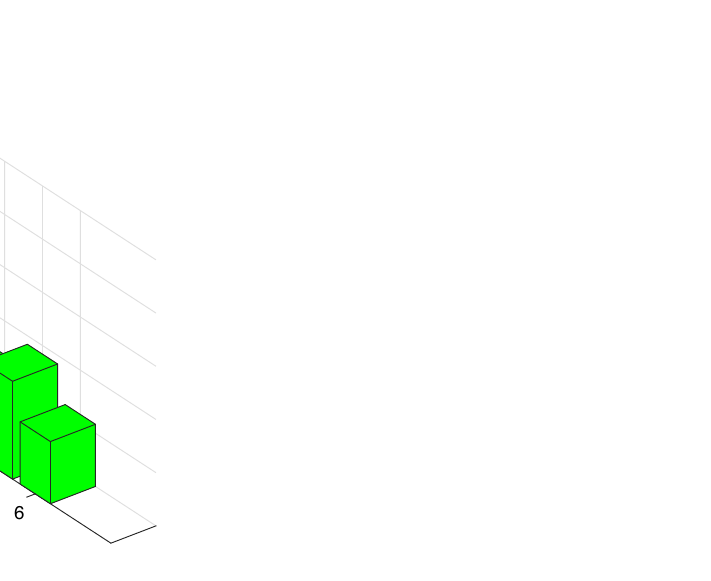
Figure 11. Optimum power generations for case